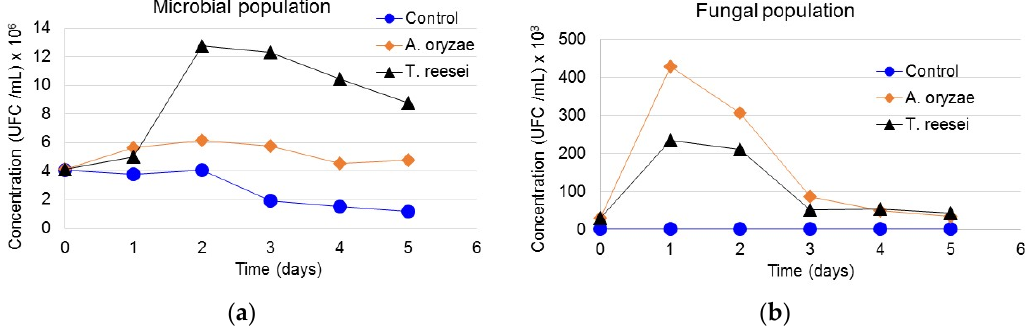
Figure 7. Interaction of microbial and fungal populations during the fungal conditioning. ( a ) microbial population; ( b ) fungal population.